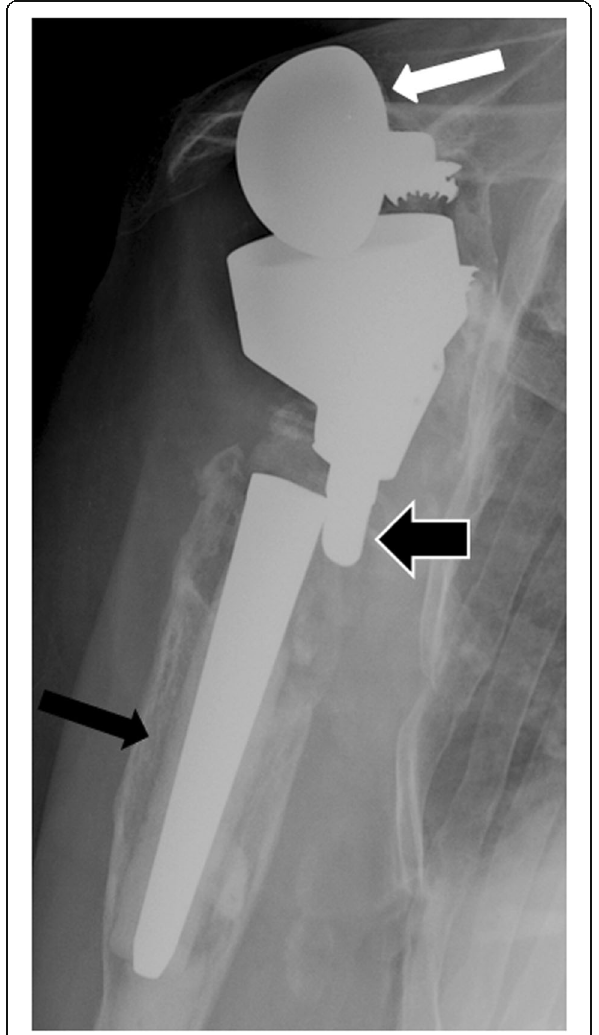
Fig. 10 Anteroposterior radiograph of a reverse shoulder arthroplasty in a 73-year-old patient shows humeral implant disjunction with unscrewing of the two components (thick arrow). This is secondary to both humeral loosening resulting in chronic abnormal mobility of the implant (black thin arrow), and glenoid loosening with the glenoid component “ wedged ” under the acromion (white thin arrow)